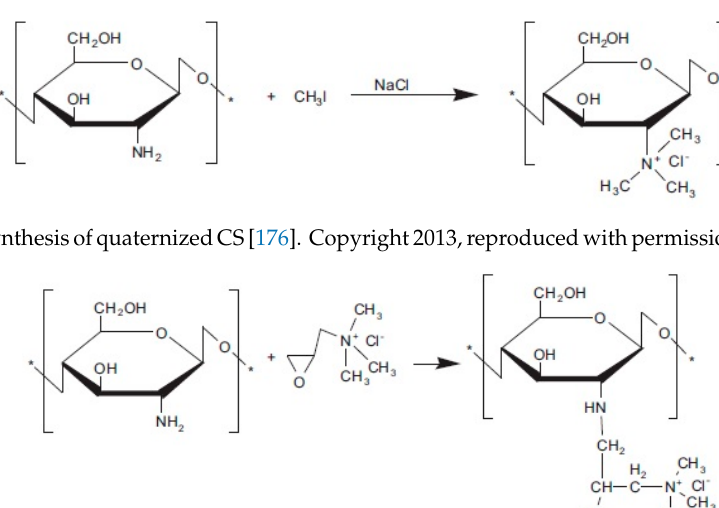
Figure 12. Synthesis of quaternized CS [176]. Copyright 2013, reproduced with permission from Elsevier